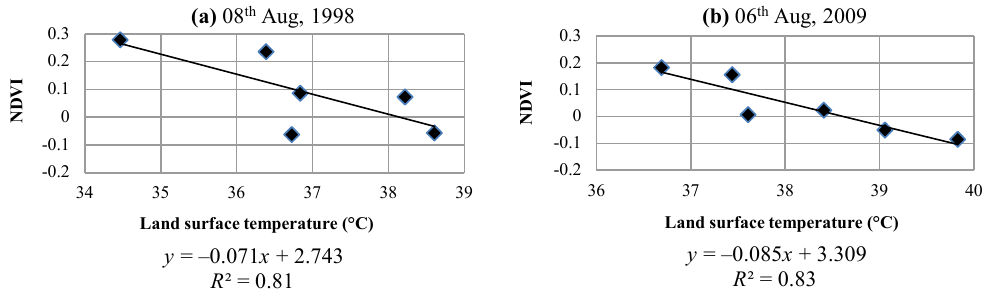
Figure 10. Linear relationship between NDVI values and land surface temperature (LST) of Landsat TM sensor: (a) 8 August 1998, (b) 6 August 2009. Table 10. Variance analysis of relationship between land surface temperature and normalized difference vegetation index (NDVI) retrieved from Landsat TM data. Landsat TM data